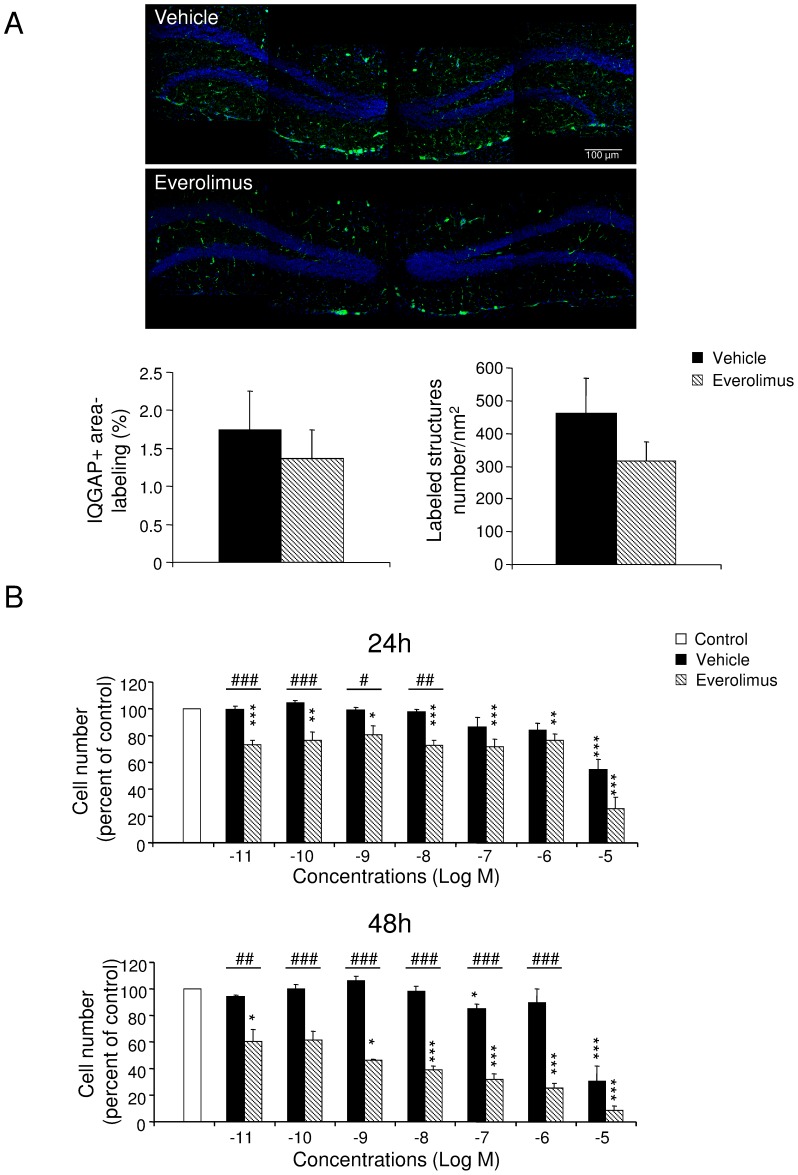
Vascular component density in hippocampus and endothelial cell proliferation in vitro.
(A) Vascular density in the dentate gyrus of the hippocampus. Upper, IQGAP1-immunolabeled vascular niches in the dentate gyrus were illustrated from brain slices of vehicle- and everolimus-treated mice (Bregma −1.68 mm). Scale bar, 100 µm. Below, Mean IQGAP1-positive surface labeling and number of branches/nm2 (+SEM) in the dentate gyrus (Mann-Whitney U-tests, p>.05). (B) Effects of increasing concentrations of vehicle and everolimus on the bEND.3 endothelial cell growth, as evaluated by endothelial cell number after 24 hours and 48 hours of treatment with vehicle or everolimus. Values are normalized to the mean number of cells in the control condition (white bar). Effect of everolimus, Kruskal-Wallis ANOVA followed by Dunn's tests *p<.05, **p<.01, ***p<.001 vs control; Effect of everolimus compared with vehicle (Mann-Whitney tests, #p<.05, ##p<.01, ###p<.001).